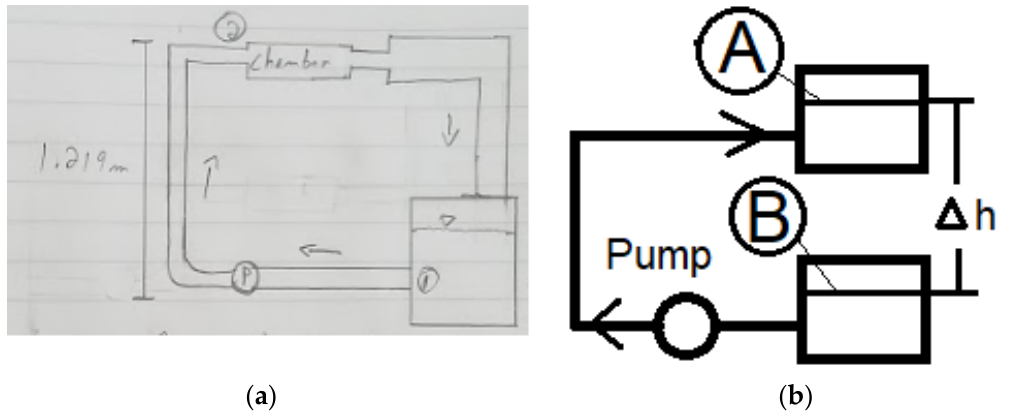
Figure 1. ( a ) Sketch of 1st design of the flow tank loop given by students and ( b ) the basic flow diagram for the calculation of pump head needed to determine the pump power.